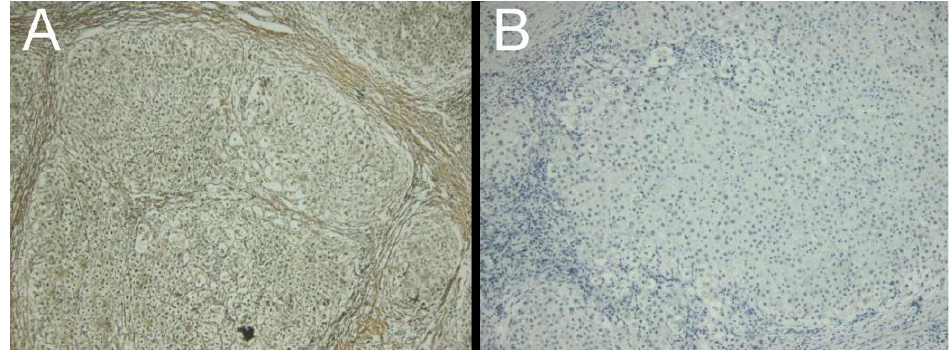
Figure 3. Liver biopsy from our patient presenting with cirrhosis secondary to previously unrecog- nized Wilson’s disease. ( A ): Gomori stain of hepatic tissue showing copper deposits; ( B ): Rhodanine stain of hepatic tissue showing copper deposits.